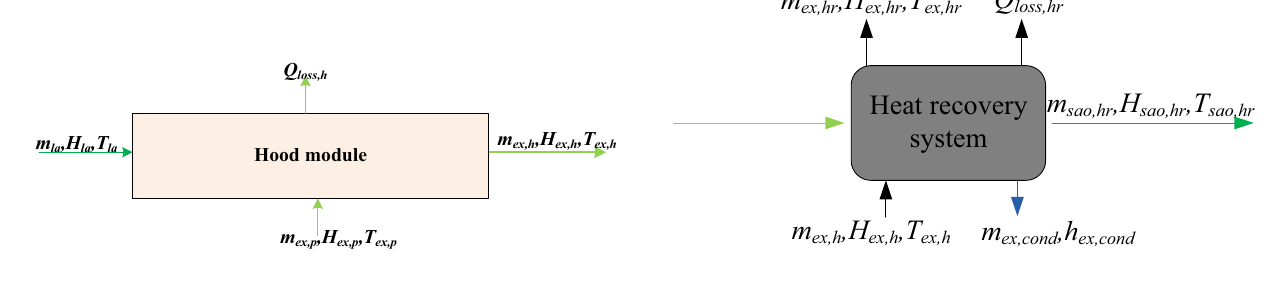
Fig. 4 Modular diagram of the hood